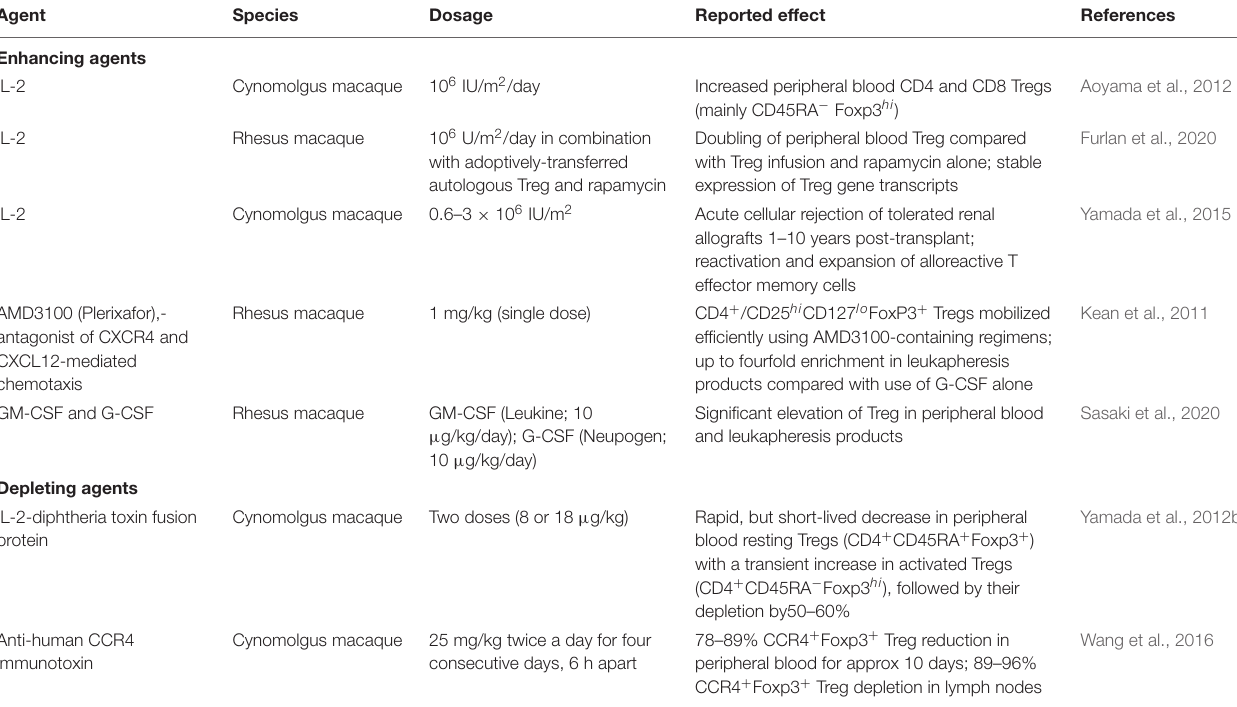
TABLE 2 | Agents used to selectively enhance or deplete Tregs in NHP